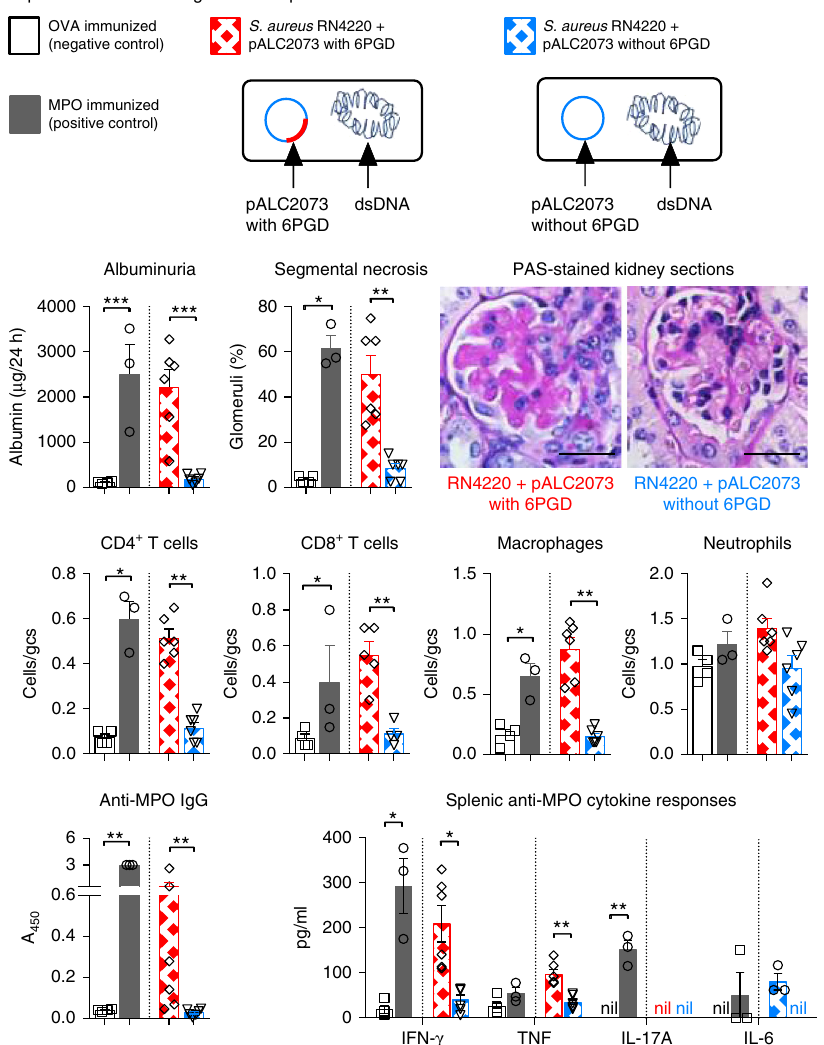
Fig. 9 Experimental anti-MPO glomerulonephritis in mice injected with S. aureus RN4220 containing pALC2073. C57BL/6 mice were immunized with either OVA (negative control, n = 4), MPO (positive control, n = 3), S. aureus RN4220 containing pALC2073 with 6PGD ( n = 6) or S. aureus RN4220 containing pALC2073 alone, without 6PGD ( n = 6). OVA and MPO were emulsi fi ed in Freund ’ s complete adjuvant; S. aureus RN4220